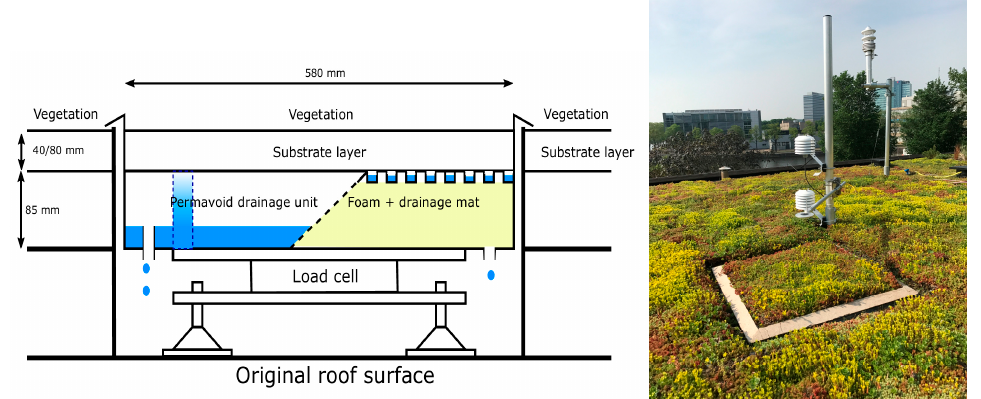
Figure 3. Lysimeter design ( left ), and ( right ) a lysimeter embedded in the green roof surface shortly after planting the sedum blankets. The drawing of the lysimeter shows the two roof designs: storage and capillary irrigation (left of the diagonal dashed line) and a conventional build up (right of the diagonal dashed line).